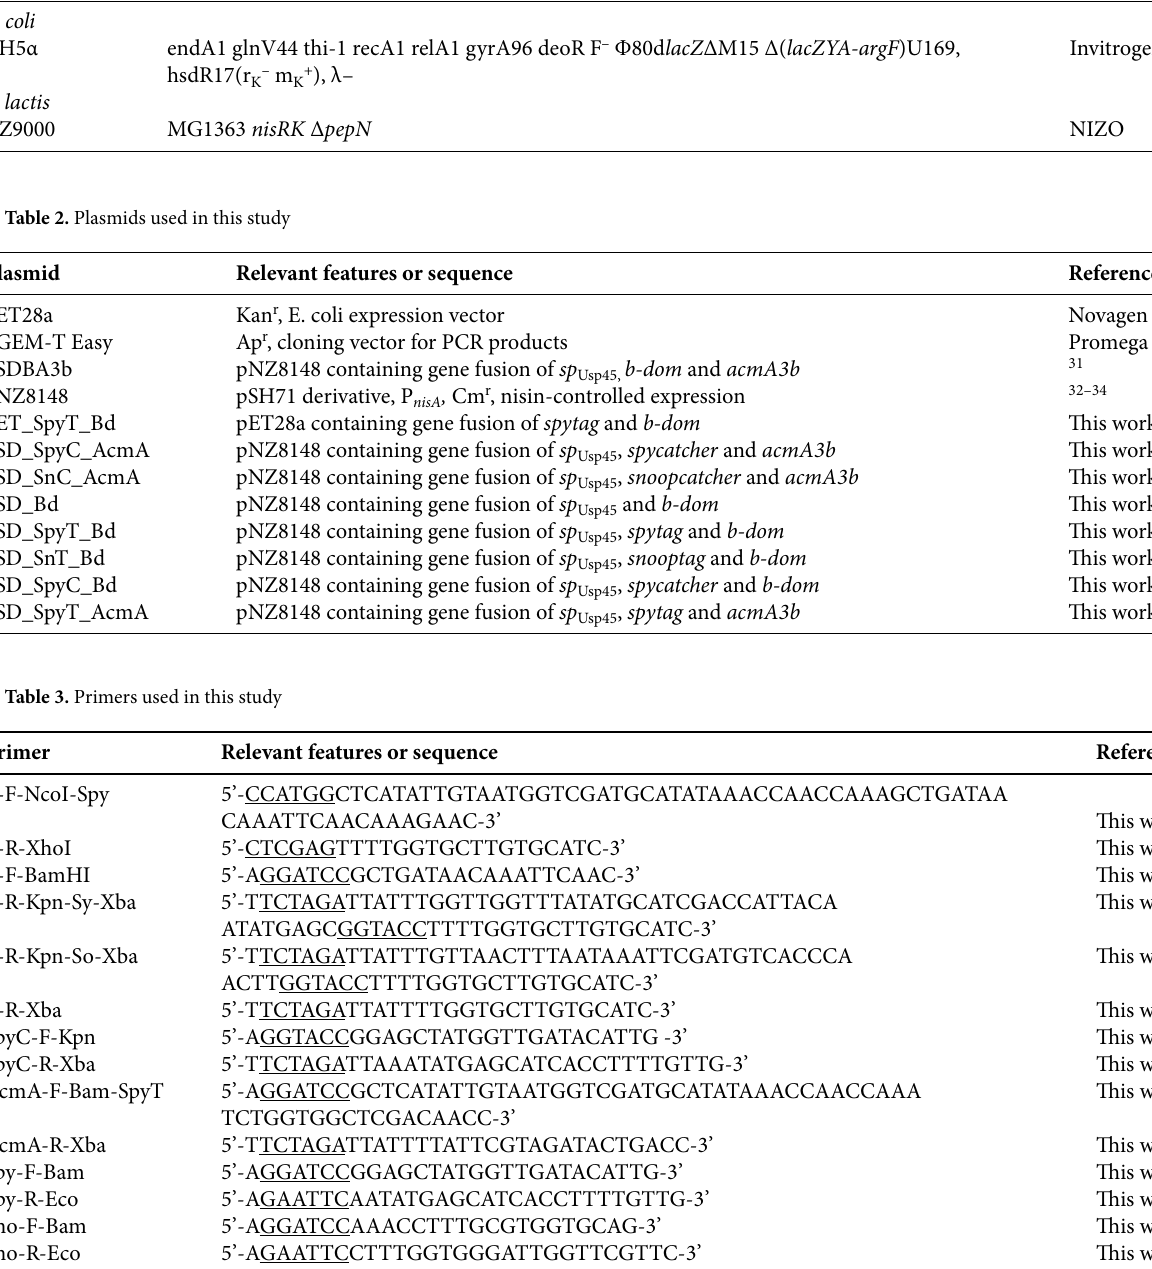
Table 1. Strains used in this study Strain Relevant features or sequence Reference